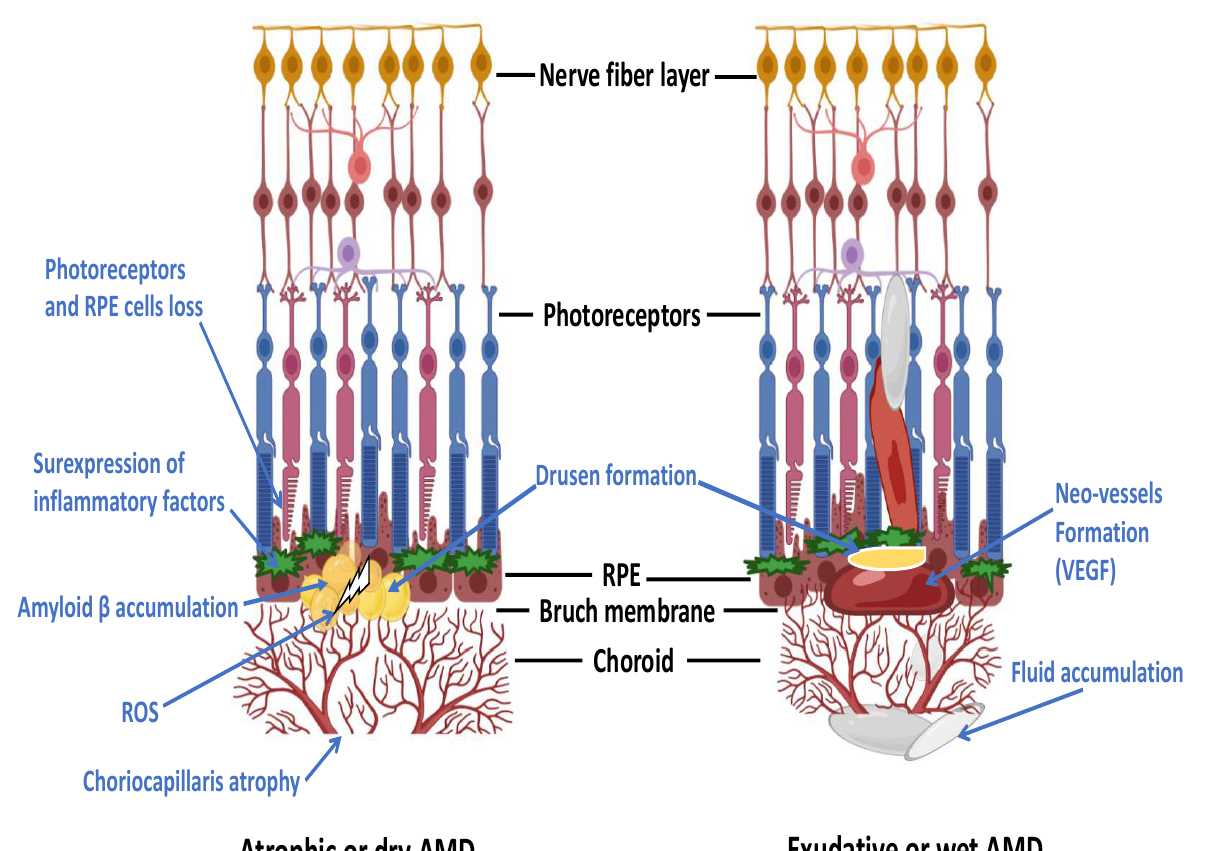
Figure 2. Diagram showing the structure of the retina, the RPE and choroid in the dry and wet forms of AMD. Late AMD is characterised by drusen formation, neovascularisation, disruption of Bruch’s membrane as well as RPE cell damage and death [14].